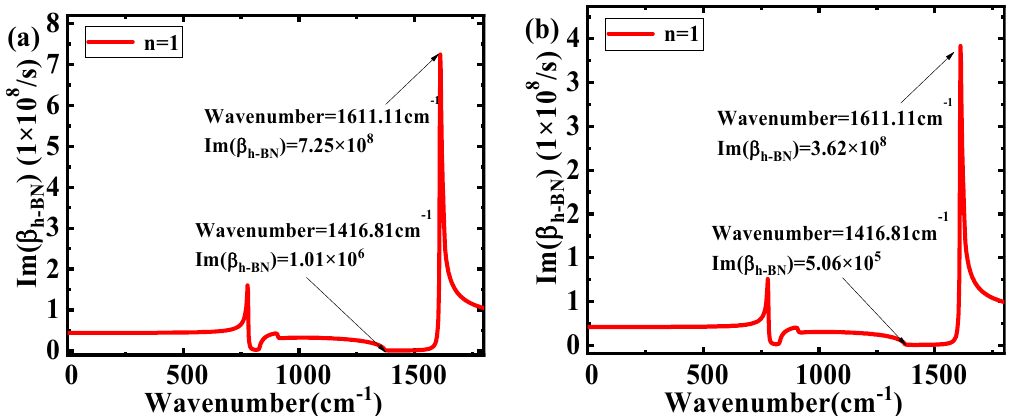
Figure 6. Im( β h ‐ BN ) as a function of wavenumber in different thicknesses of h ‐ BN: ( a ) ε 1 = 1, ε 2 = 3.9, d = 50 nm; and ( b ) ε 1 = 1, ε 2 = 3.9, d = 100 nm.